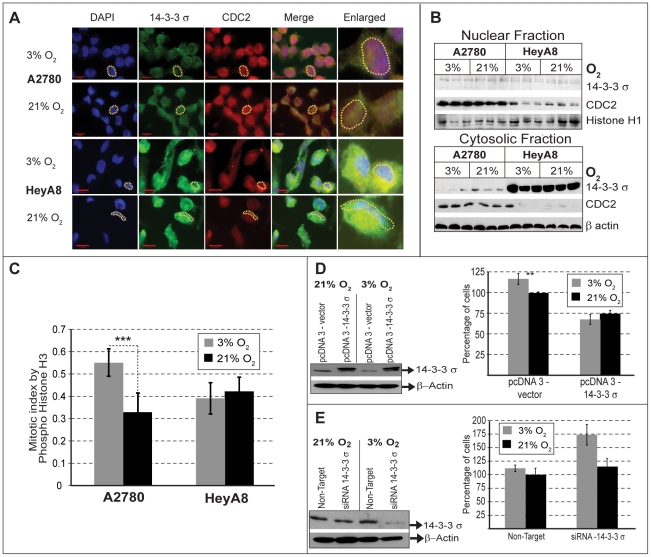
14-3-3 σand O2 sensitivity.(A) Cellular localization by immunofluoresence shows that 14-3-3 σ (Green) is located in the cytoplasm and CDC2 (Red) is present in the nucleus (Blue). Compared to O2 sensitive A2780 cells, the level of 14-3-3 σ is higher and CDC2 is low in the O2 insensitive HeyA8 cells. In the O2 sensitive A2780, 14-3-3 σ is localized both in the nucleus and cytoplasm at 21% O2. (A dotted yellow line, outlines a representative nuclei to indicate relative localization of 14-3-3 σ and CDC2 in these cells). (B) Western blot analysis of nuclear and cytoplasmic fractions show low levels of 14-3-3 σ in the nucleus compared to cytoplasm, with increased amounts of 14-3-3 σ being present in the cytoplasm of the O2 insensitive HeyA8 cells. The level of CDC2 is higher both in the nucleus and cytoplasm of the O2 sensitive A2780, but present in lower amount only in the nucleus of O2 insensitive HeyA8 cells. Histone H1 and β−actin were used as loading controls for nuclear and cytoplasmic fractions, respectively. (C) Mitotic cells were determined by counting the cells that stained positively for a mitosis specific marker, Phospho-Histone H3 from the total cell population. Mitotic fractions present at 3% or 21% O2 were counted in both A2780 and HeyA8 and represented as bar graph. A significant increase in mitotic index (p>0.001, indicated by asterisk) was observed in the O2 sensitive A2780 at 3% O2, but not in the O2 insensitive HeyA8 cells. (D) Over-expression of 14-3-3 σ in the O2 sensitive A2780 (Western Blot) results in loss of O2 sensitivity (Bar graph). For the cells transfected with empty vector (mock transfection) or 14-3-3 σ over-expression construct, the percent of cell proliferation was compared with proliferation of mock transfected cells grown under standard tissue culture conditions consisting of 21% O2 (ambient), and (E) in the converse experiment performed with O2 insensitive HeyA8, reducing the levels of 14-3-3 σ by siRNA (Western blot) results in restoration of O2 sensitivity (Bar graph). For the cells transfected with scrambled siRNA (mock transfection) or siRNA against 14-3-3 σ, the percent of cell proliferation was compared with proliferation of mock transfected cells grown under standard tissue culture conditions consisting of 21% O2.